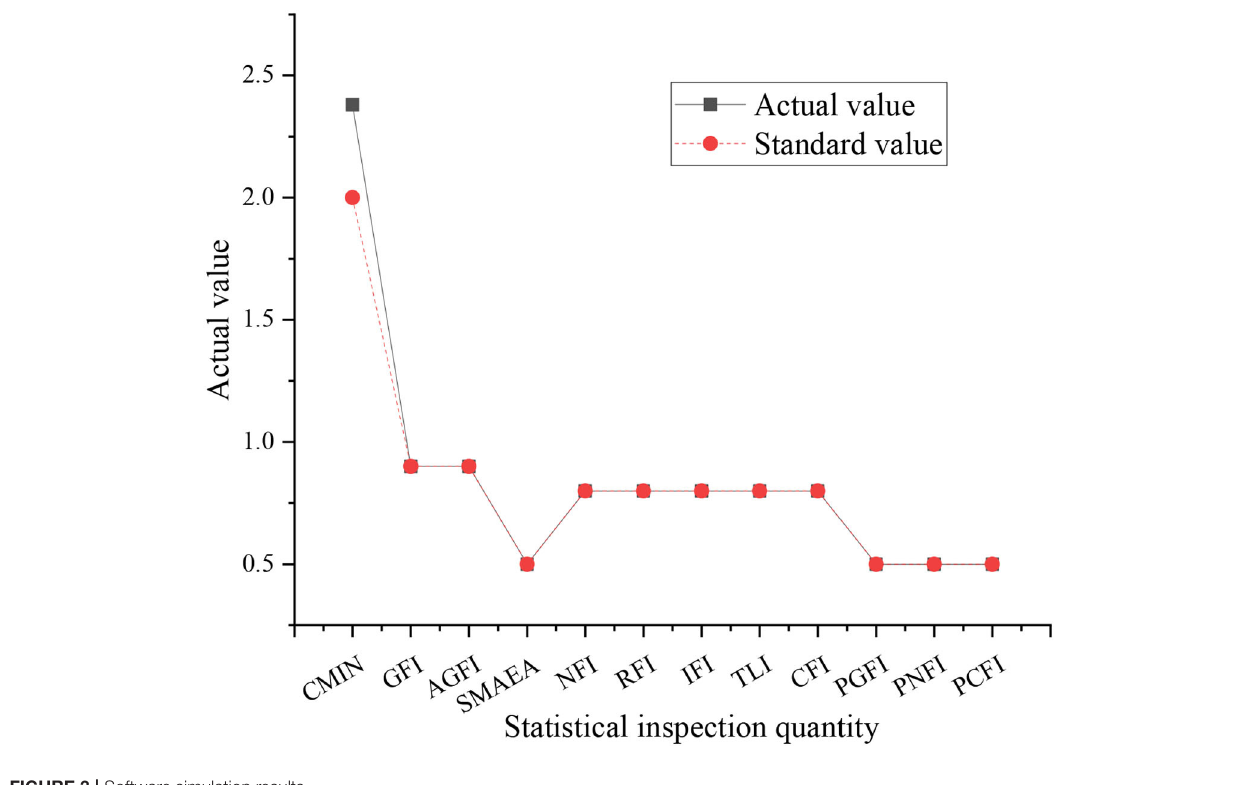
FIGURE 3 | Software simulation results.